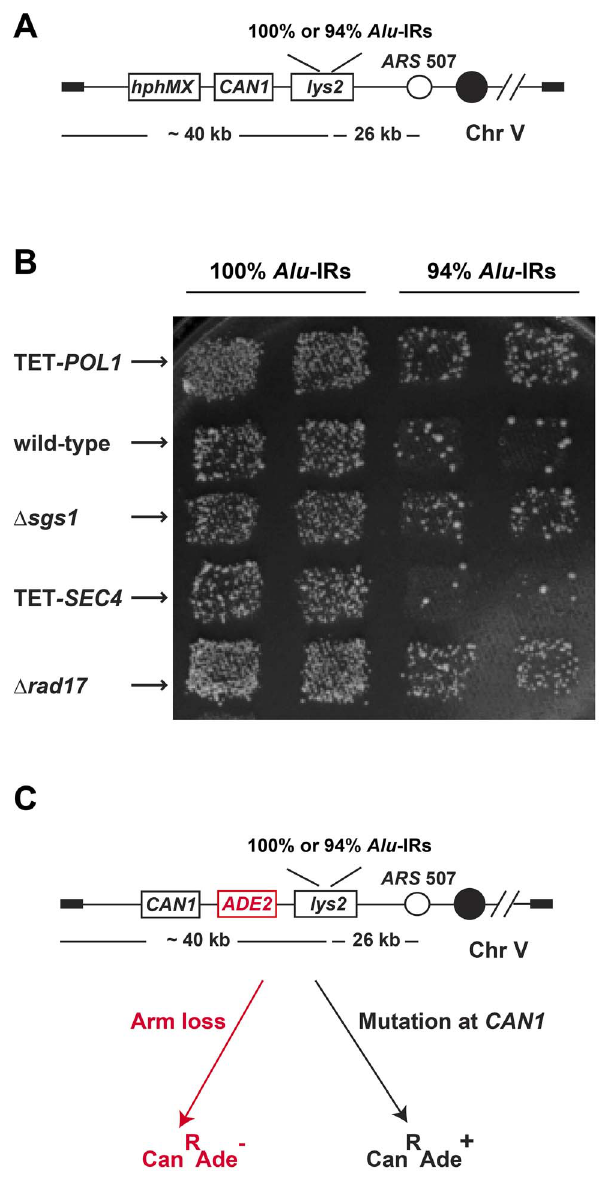
Figure 1. The genome-wide screen to identify hyper-GCR mutants. ( A ) Experimental construct in the query strains. 100% homologous or 94% homeologous Alu -IRs were inserted into the left arm of chromosome V. The selectable marker hphMX for the presence of the chromosomal fragment containing the repeats and the counterselectable marker CAN1 used to assay GCR events are depicted. ( B ) Representative plate showing papillae on canavanine-containing medium reflecting the levels of Alu -IR-induced GCRs in wild-type and mutants. Columns are duplicates of query strains containing 100% homologous or 94% homeologous Alu -IRs. Each row is a tester strain containing the corresponding mutation. ( C ) Experimental construct for verifying the effect of hyper-GCR mutants obtained from the screen. ADE2 was inserted between CAN1 and the repeats. As a result, GCR events appear as red Can R colonies and mutations at CAN1 give rise to white Can R colonies on canavanine-containing medium with low amounts of